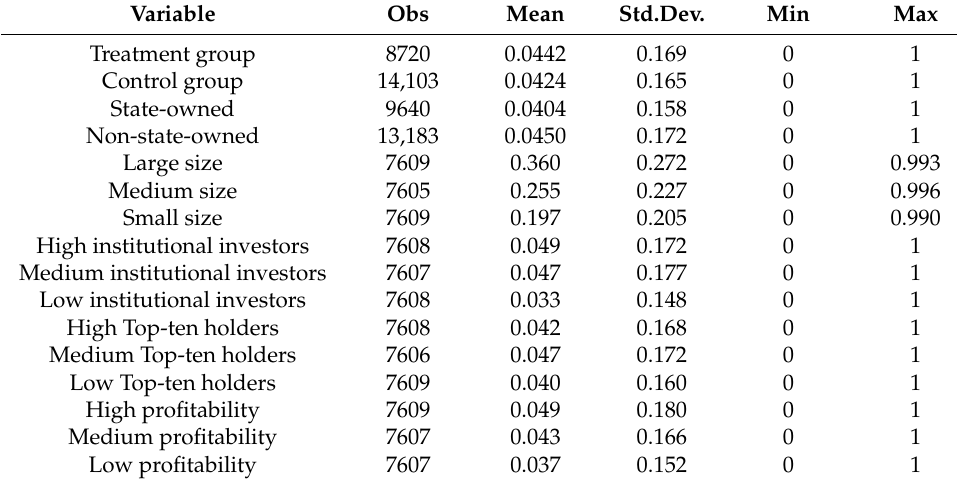
Table 3. Summary statistics of green innovation for the